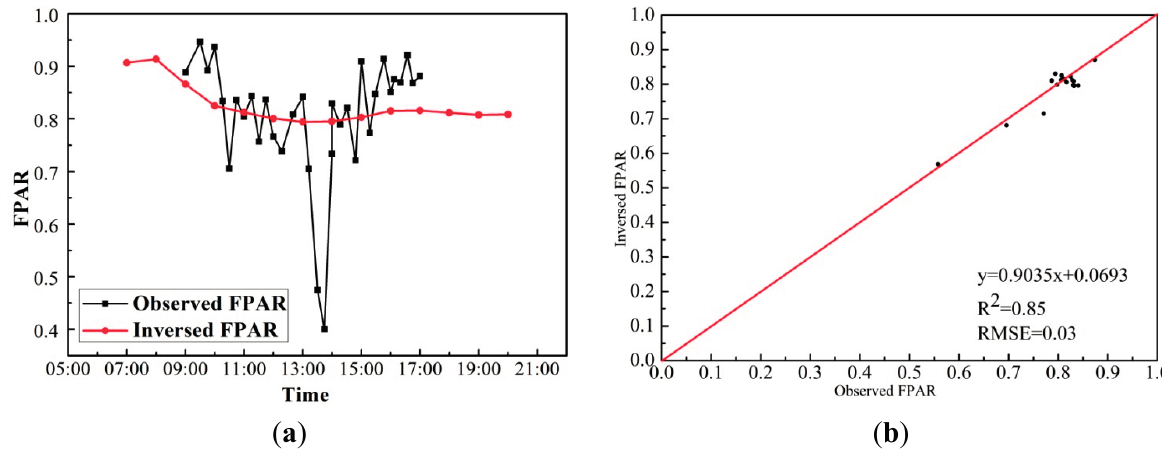
Figure 6. Comparison of observed and inversed FPAR: ( a ) diurnal change curves for observed and inversed FPAR; ( b ) scatterplots between observed and inversed